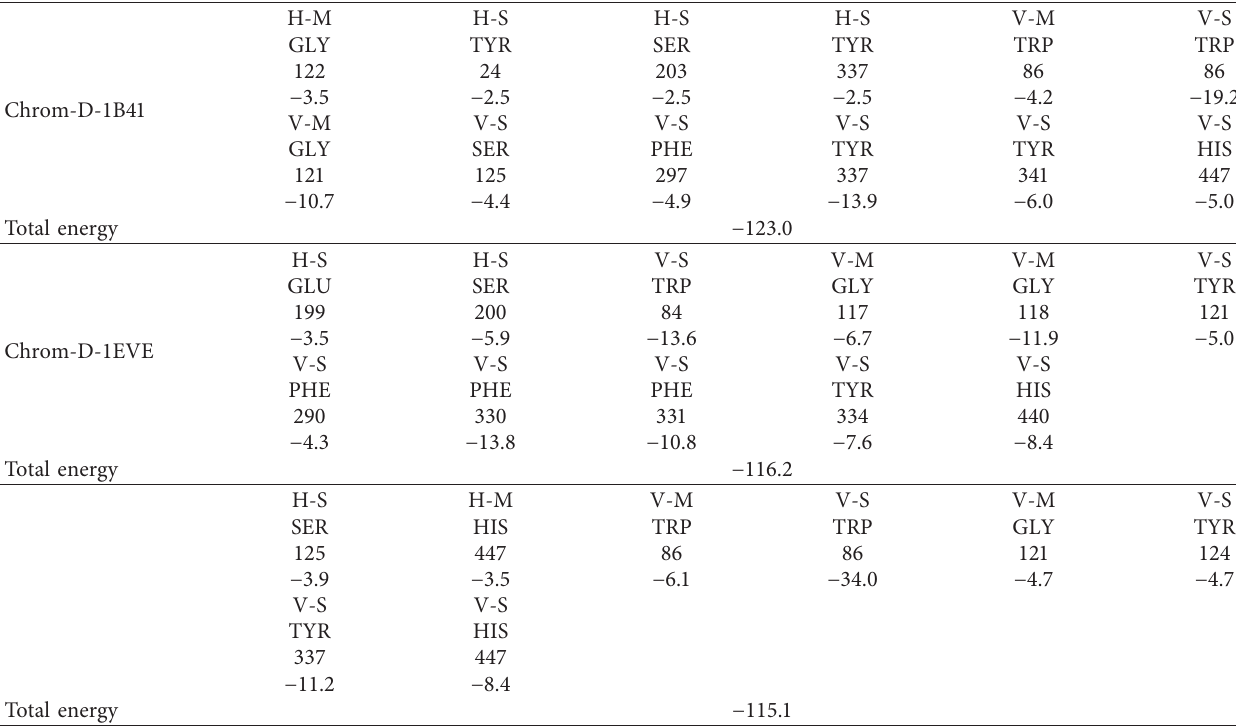
Table 7: Protein-Chrom-D contact interaction profile analysis. The energy values are given in kcal.mol − 1 .